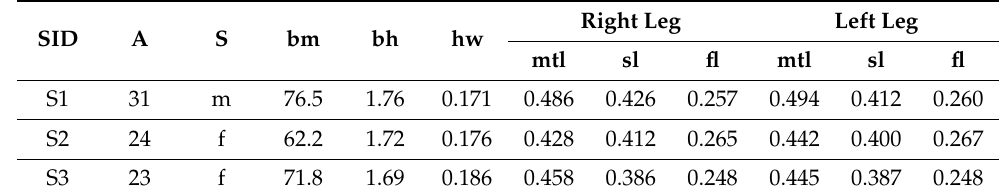
Table 1. Relevant anthropometric data of the subjects with SID = subject identification, A = age in years, S = sex (m = male, f = female), bm = body mass [kg], bh = body height [m], hw = hip width [m], mtl = morphological thigh length [m], sl = shank length [m], fl = foot length